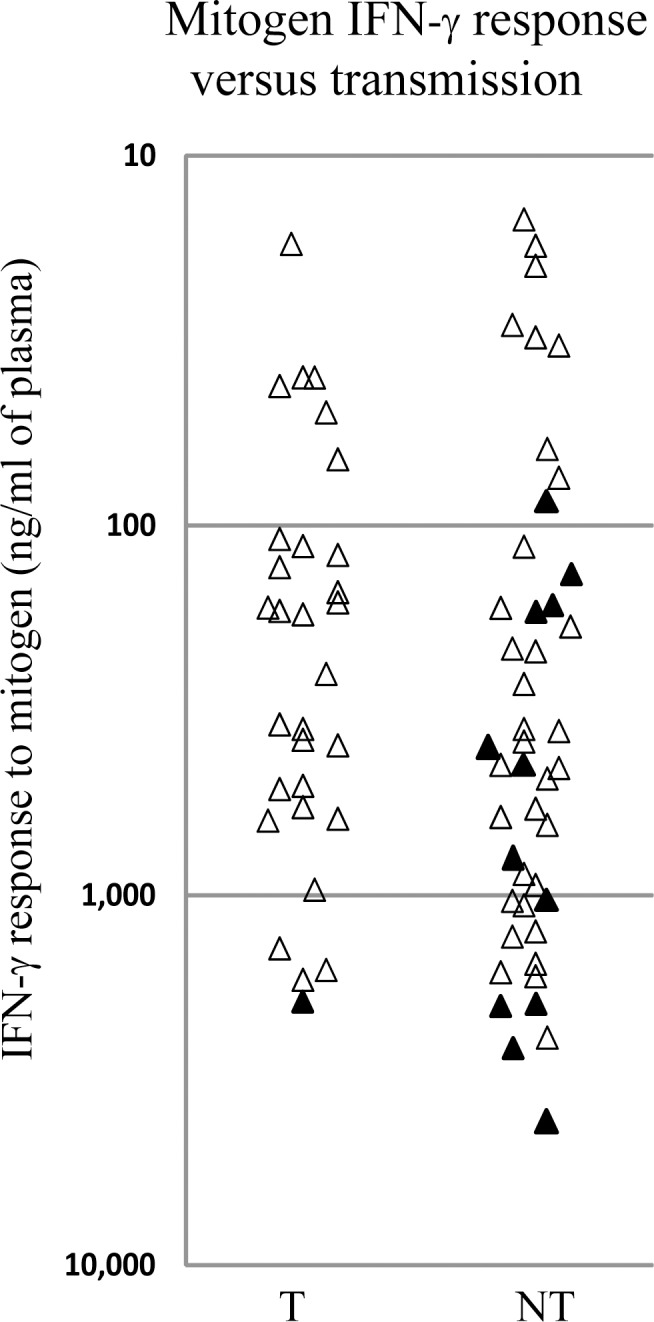
Low IFN-γ RR in non transmitters does not stem primarily from high IFN-γ level caused by mitogen activation.Comparison of IFN-γ levels after mitogen activation in transmitters and non transmitters. Women with IFN-γ RR <1.8% are marked with filled triangles. T = transmitters, NT = non transmitters.